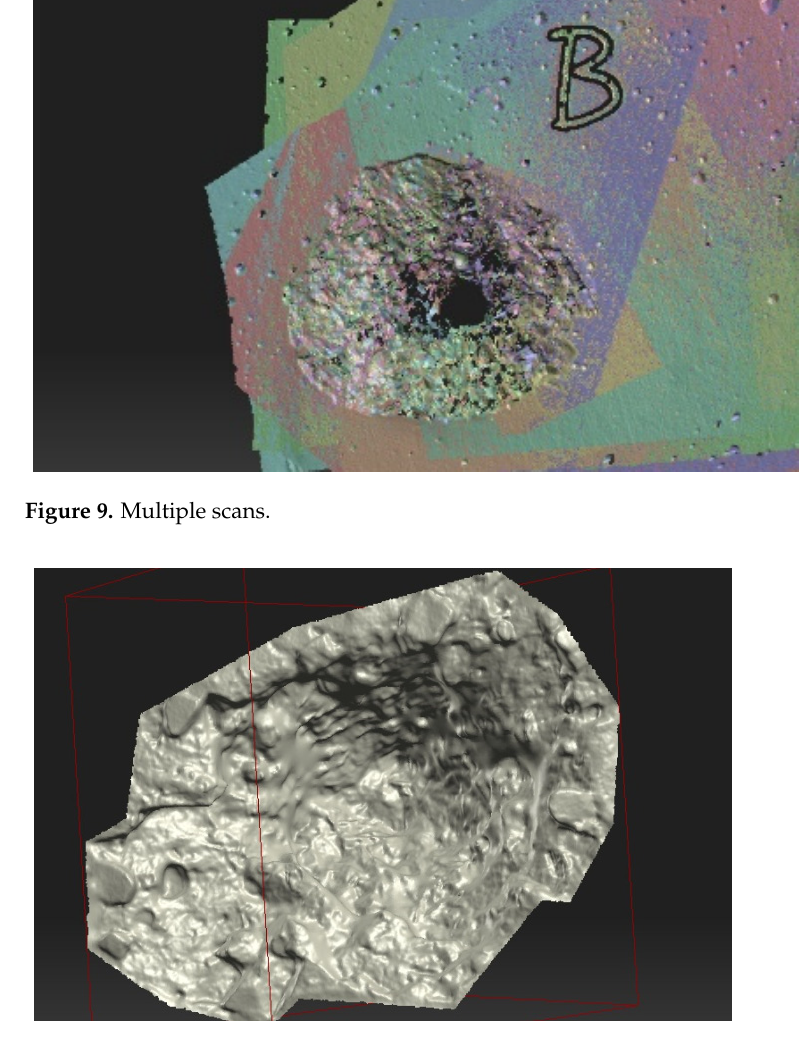
Figure 10. Spatial visualisation of the formed